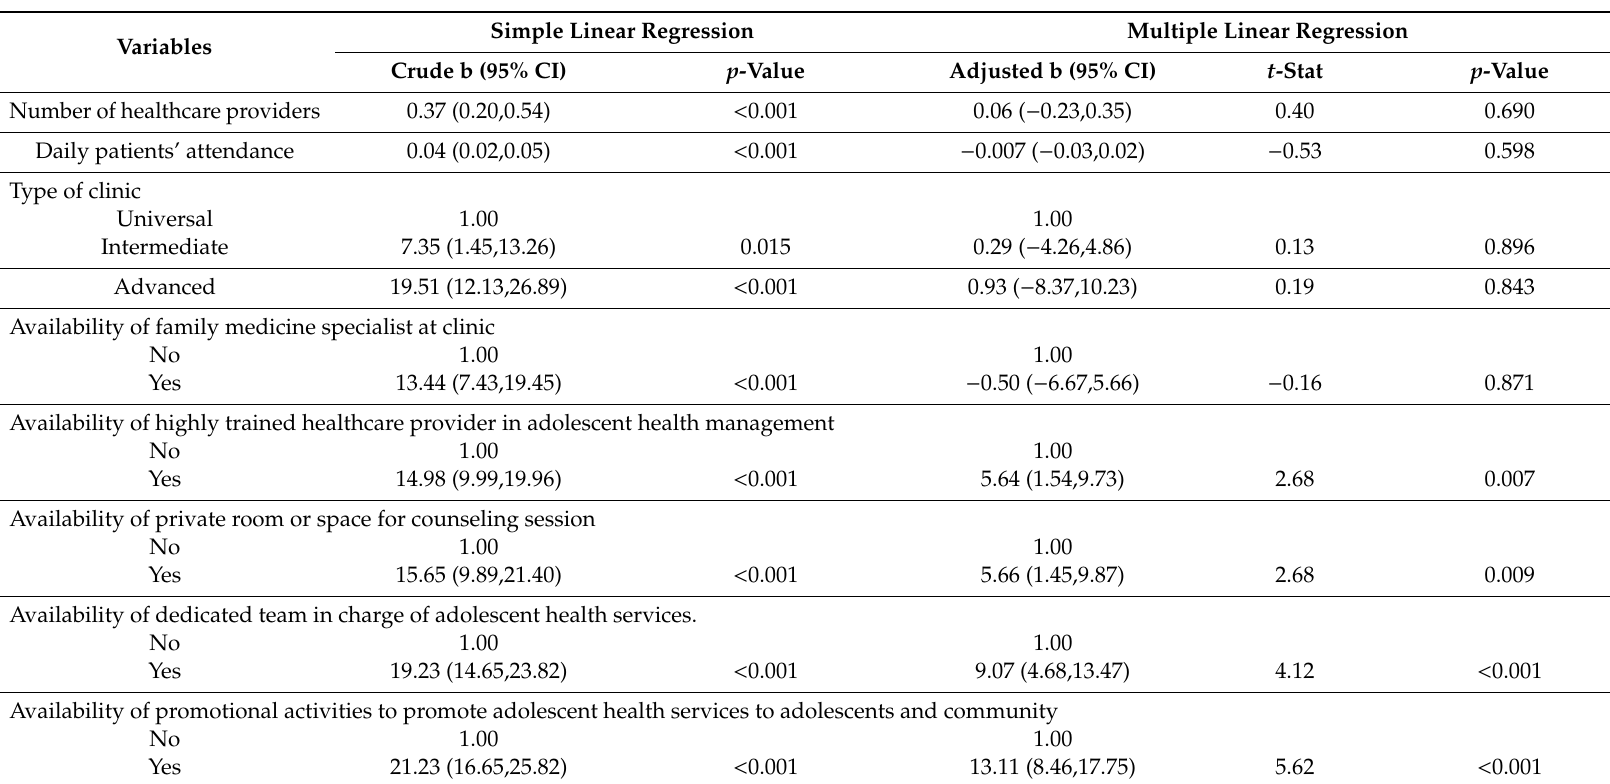
Table 1. Factors related with clinic assessment score among clinics in Kelantan by simple and multiple linear regression ( n =